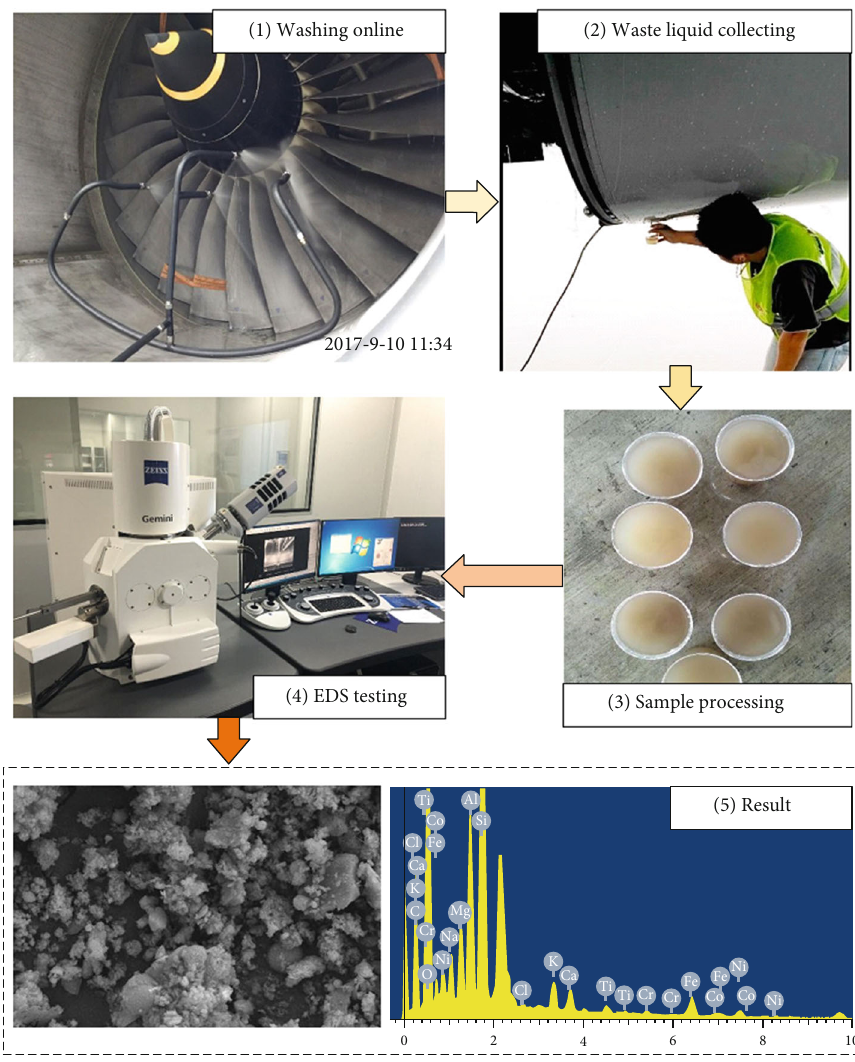
Figure 1: Collection and treatment of scale.